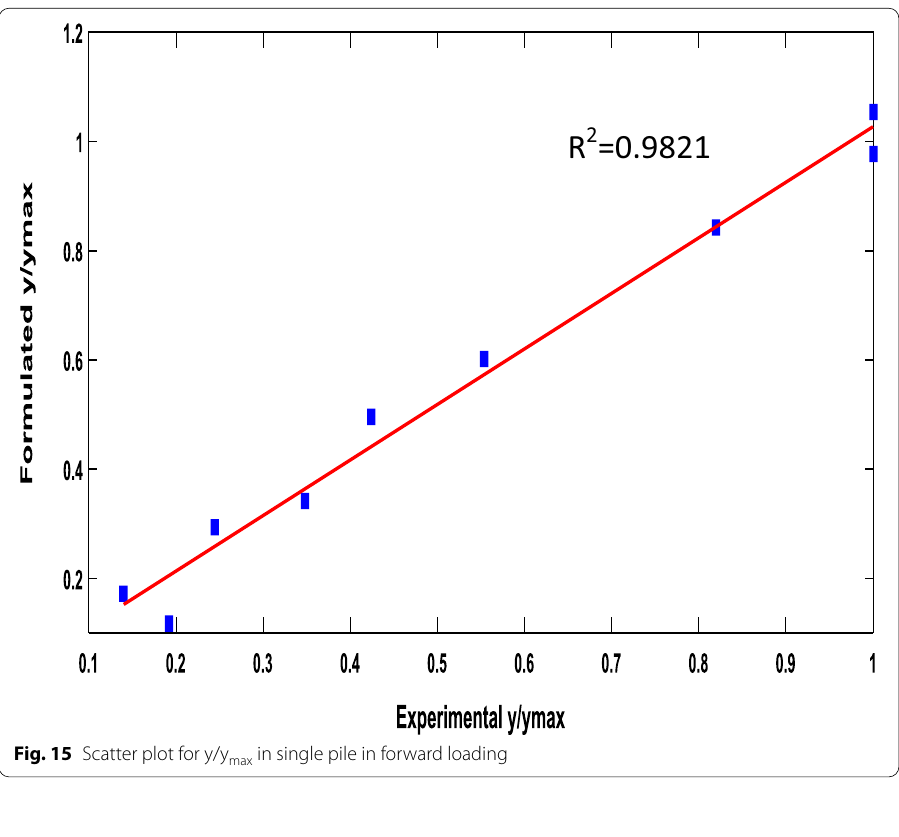
Fig. 15 Scatter plot for y/y max in single pile in forward loading